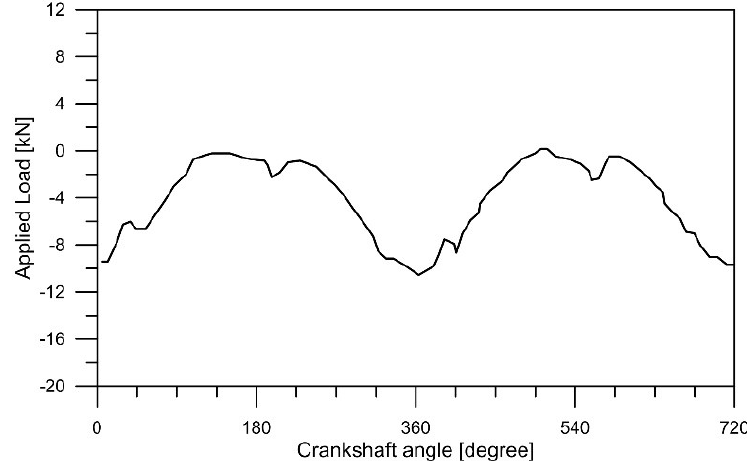
Figure 7. Experimental load profile used for the validation, measured by Moreau et al. at 5500 rpm and full load [32].